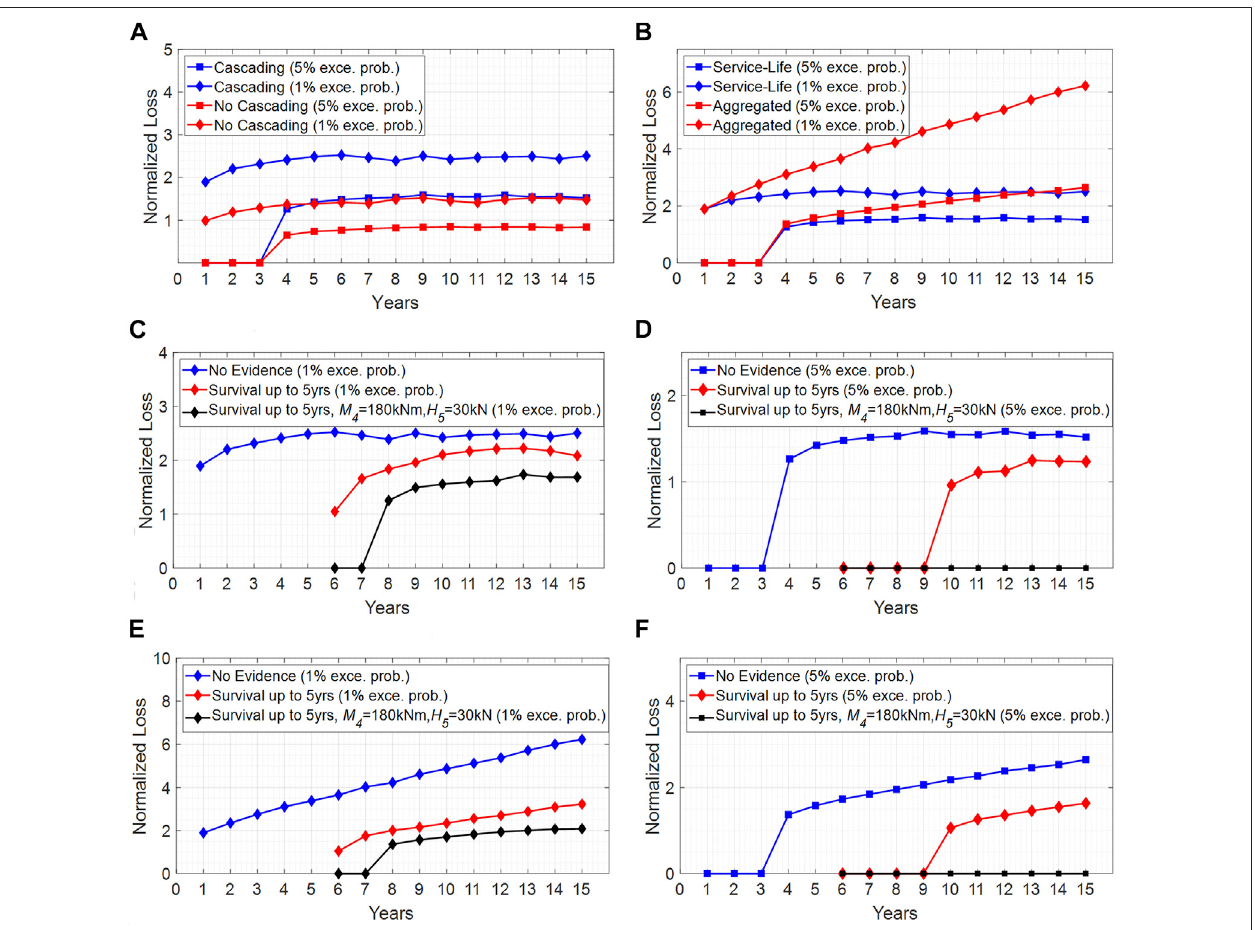
FIGURE 12 | (A) Normalized loss corresponding to 1 and 5% exceedance probability for varying service-life, with and without the consideration of the effect of cascading failure, (B) normalized service-life loss and aggregated loss corresponding to 1 and 5% exceedance probability for varying service-life, (C) the prior and posterior normalized service-life loss corresponding to (C) 1% and (D) 5% exceedance probability for varying service-life, (E) the prior and posterior normalized aggregate loss corresponding to (E) 1% and (F) 5% exceedance probability for varying service-life 1 and 15 years.